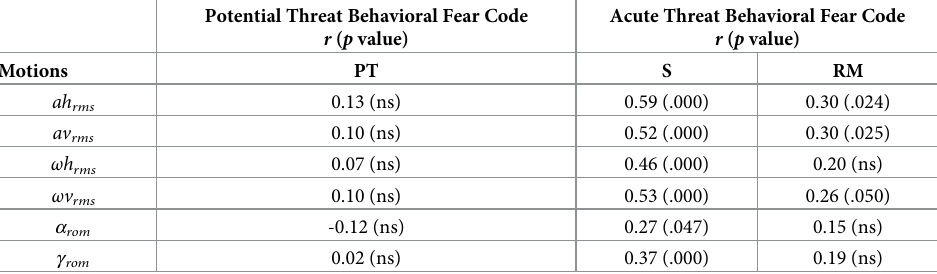
Table 4. Pearson correlations between behavioral fear codes and IMU-derived movement variables.